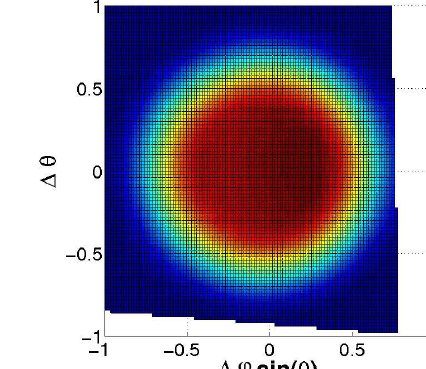
Fig. 4. Azimuth and zenith absolute Sun variations per second in Valladolid site during the winter, on the left, and during the summer, on the right.